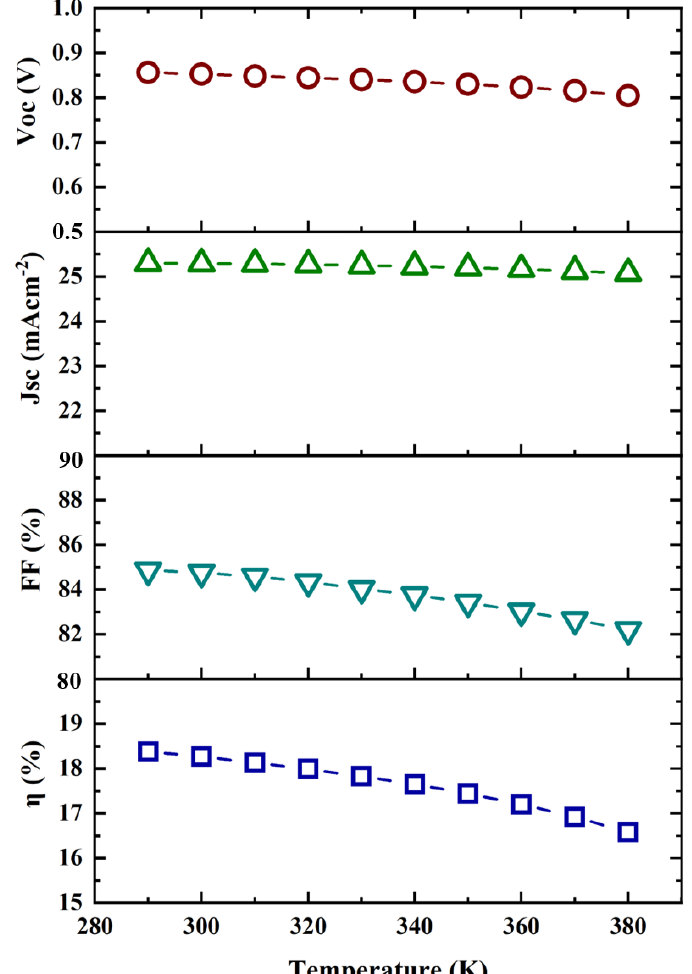
Figure 8. Effect of temperature versus V oc , J sc , FF, and η.